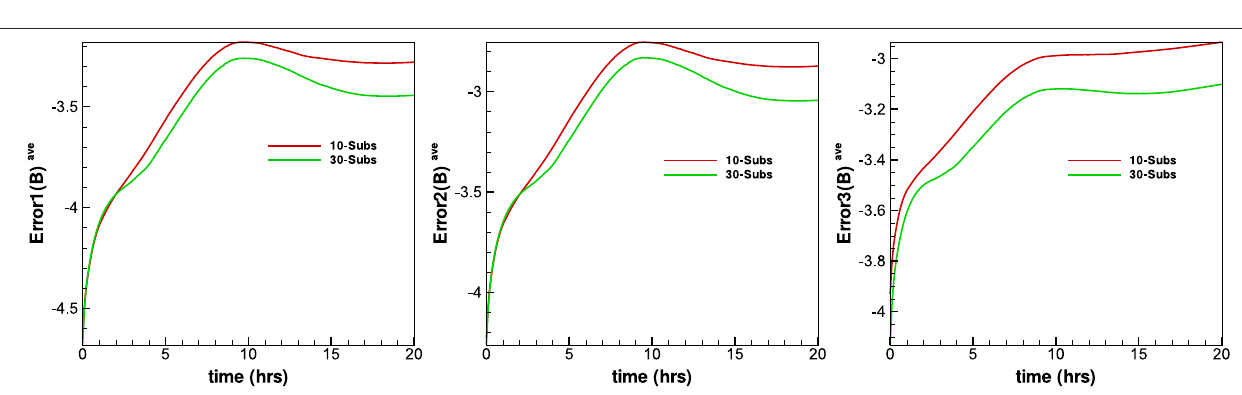
FIGURE 14 | The temporal evolution of the log 10 Error1 (B) ave and log 10 Error2 (B) ave and log 10 Error3 (B) ave from the projection method with different maximal sub-iterations.